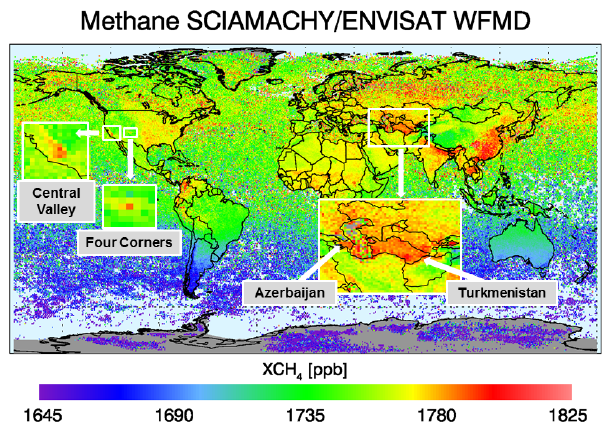
Figure 1. Year 2004 SCIAMACHY WFMD X CH 4 at 0.5 ◦ × 0.5 ◦ resolution. The source regions studied in this paper are indicated: Central Valley (California, USA), the Four Corners area (south- western USA), Azerbaijan, and